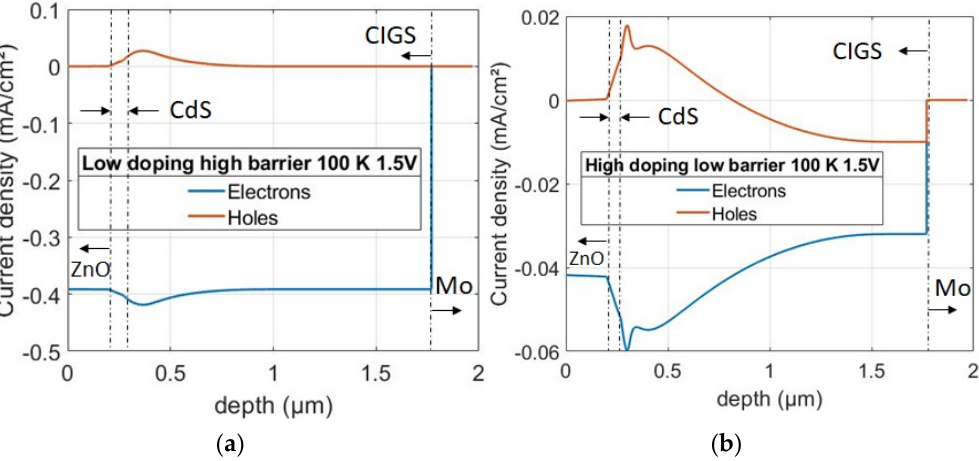
Figure 12. Simulated electron and hole currents at 100 K, a bias of 1.5 V and a transparency of 100% in a